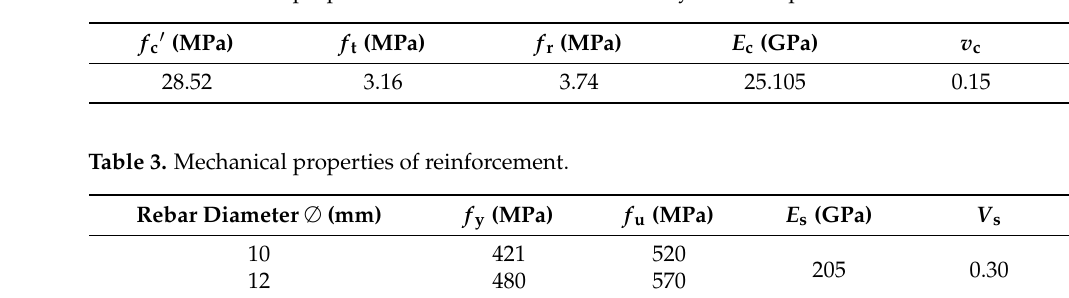
Table 2. Mechanical properties of concrete from the tested cylindrical specimens.